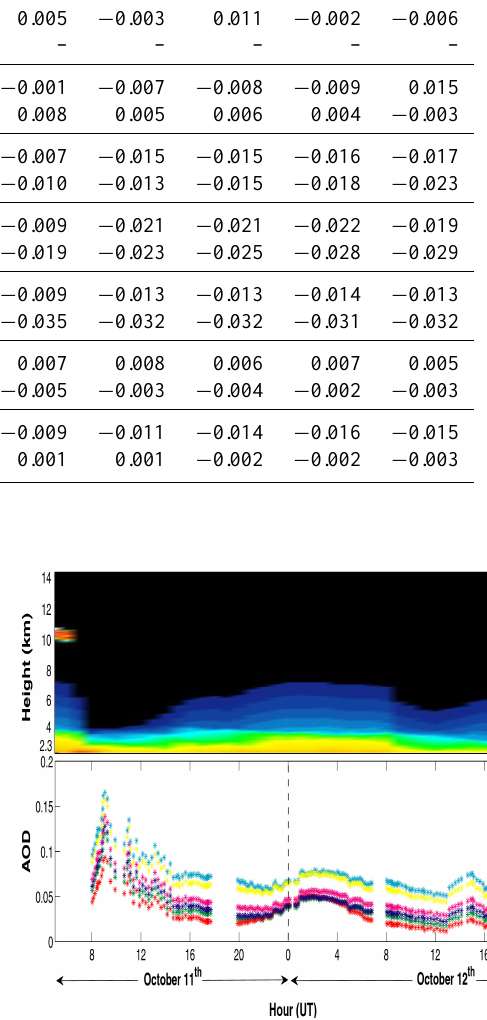
Fig. 2. τ a evolution during six days and five nights on August 2011, using AERONET data for daytime and lunar CE-1 data for nocturnal period. MPL corrected backscatter cross-sections obtained at Santa Cruz station from the Iza˜na Observatory level in upper panel. Fig. 3. CE-1 τ a on 11 and 12 October 2011, with MPL corrected backscatter cross-sections for the same period from the Iza˜na Observatory level (upper panel).